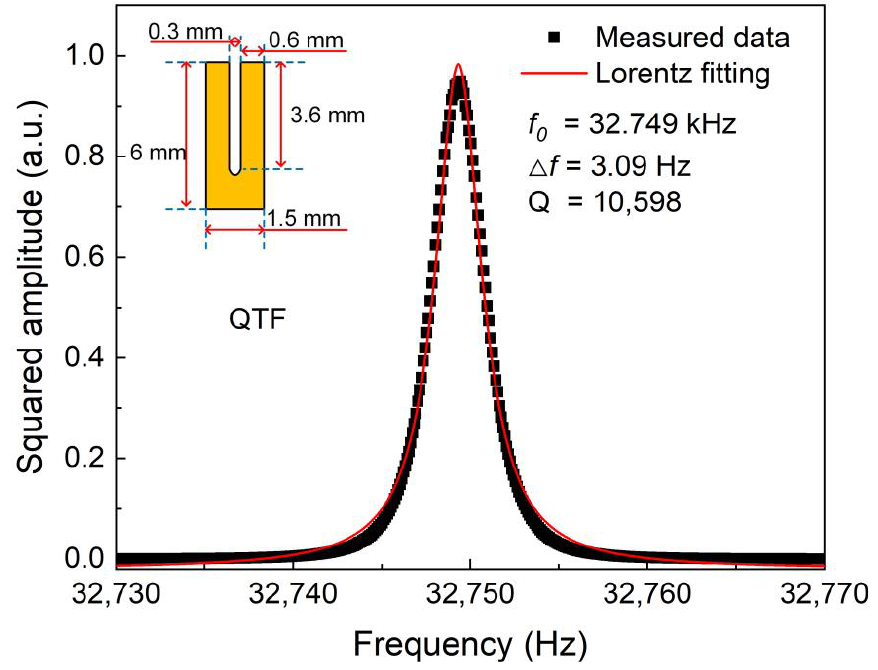
Figure 6. Frequency response of the used QTF.